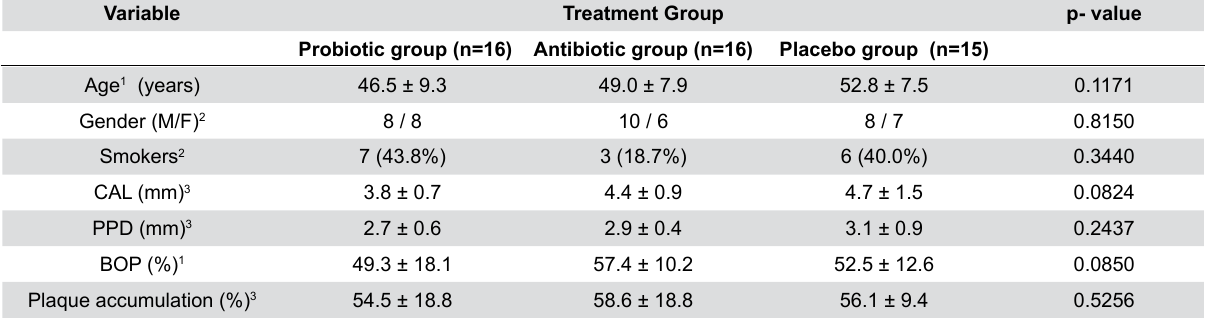
Table 1- Baseline data of patients in the treatment